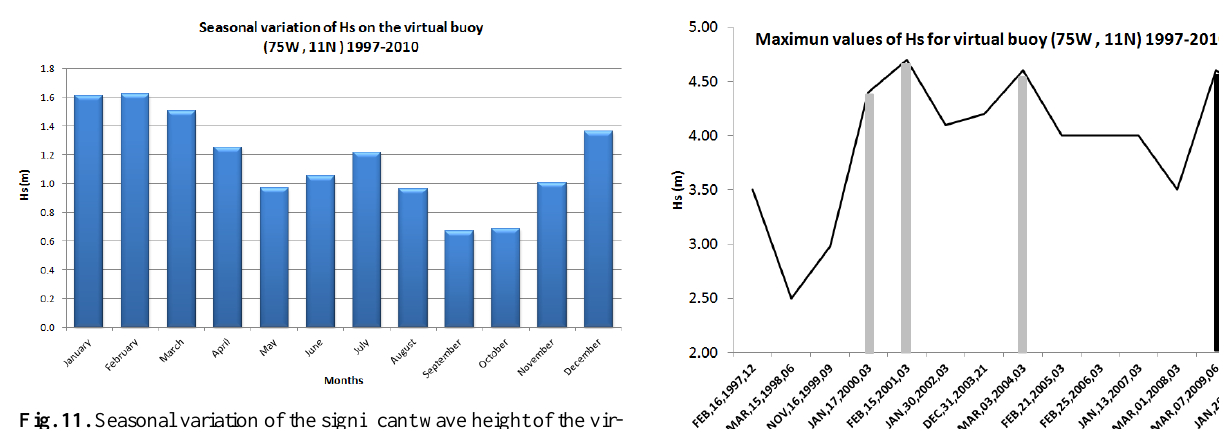
Fig. 11. Seasonal variation of the significant wave height of the vir- tual buoy.